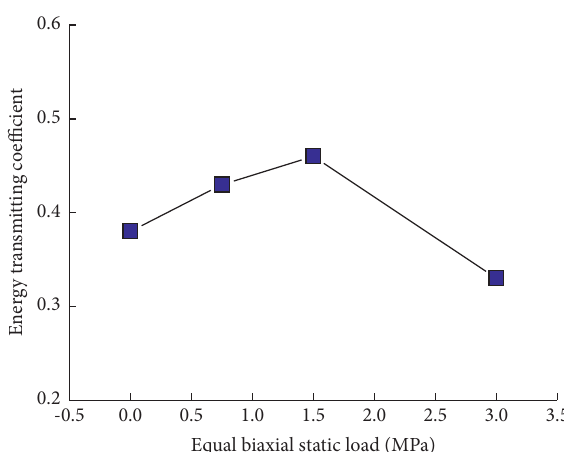
Figure 11: Energy intensities of incident and transmitted stress waves in intact rock under different lateral static load coefficients.